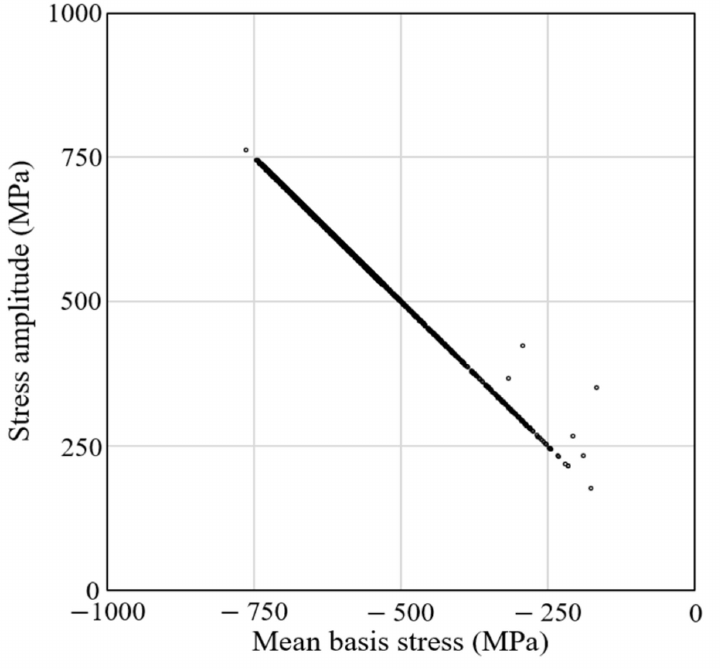
Figure 8. Cyclic stress features of the non-prestressed die parts